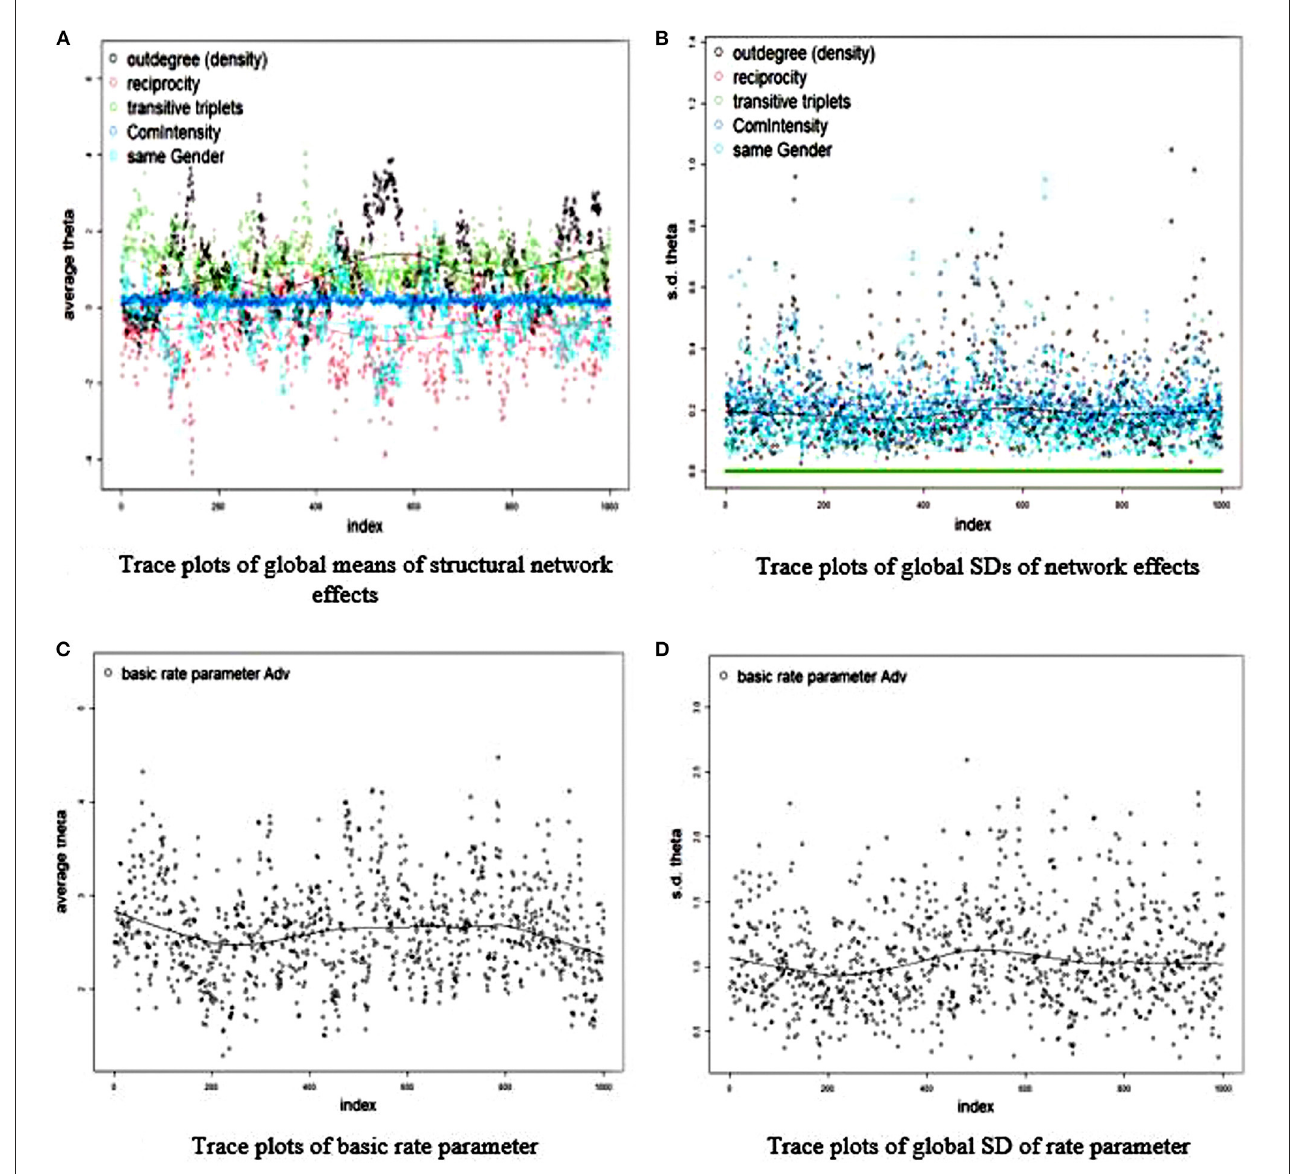
FIGURE2 (A–D) Trace plot for convergence diagnosis. Second estimation (much better, but not acceptable convergence). SD, standard deviation; Adv, name of key network; Theta, estimated coefficient; Index, iteration in estimation chain.